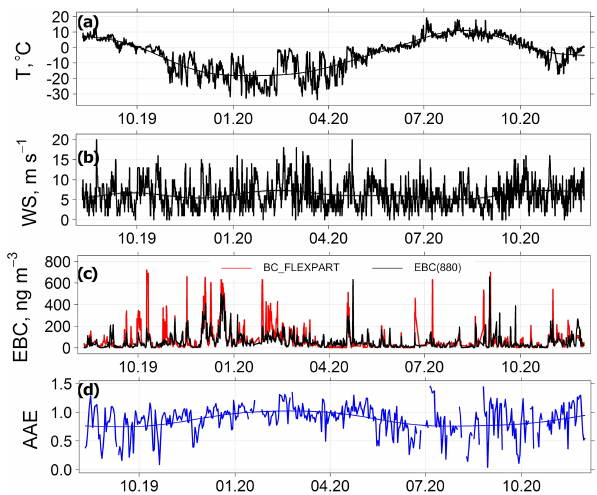
Figure 2. Meteorological conditions with respect to (a) mean tem- perature and (b) wind speed (data were smoothed to show long-term variations), (c) time-series of 24h median EBC (black) and model BC using ECLIPSEv6-CAMS emissions (red), and (d) 24h aver- age absorption Ångström exponent (AAE) measured at Island Bely station from 10 August 2019 to 30 November 2020 (date format in